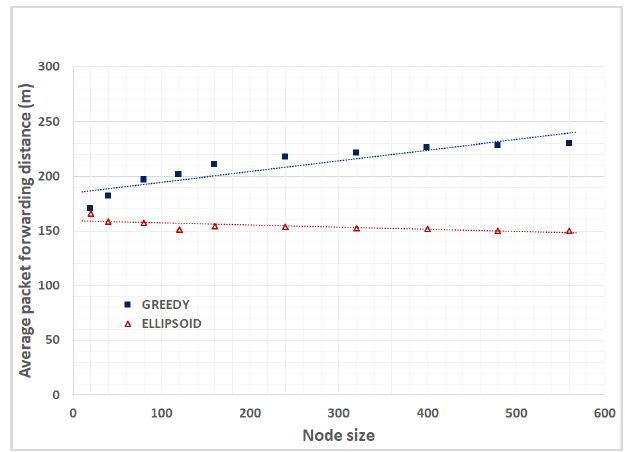
Figure 3. Packet forwarding distance averages with trendlines (MANET case).